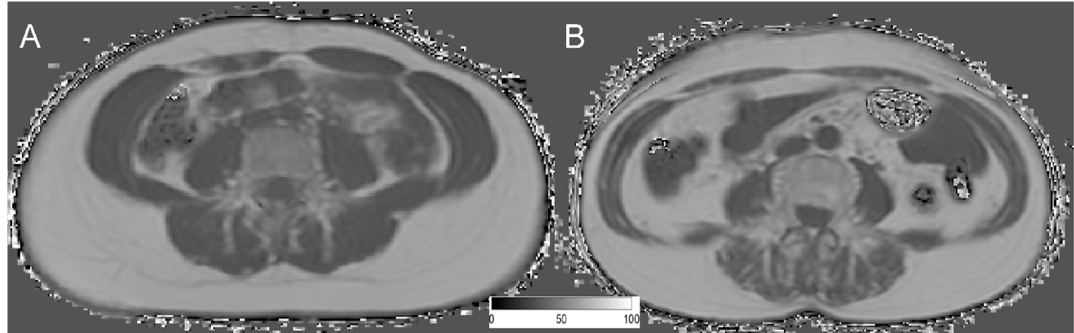
Figure 3. Representative PDFF maps on the level of L4 of a 23-year-old woman ( A ) BMI: 22.81 kg/m 2 ; mean PDFF abdominal muscles: 1.569%; mean PDFF psoas muscle: 3.320%; mean PDFF erector spinae: 9.547%; and a 77-year-old woman ( B ) BMI: 23.39 kg/m 2 ; mean PDFF abdominal muscles: 13.992%; mean PDFF psoas muscle: 3.162%; mean PDFF erector spinae: 29.698%.